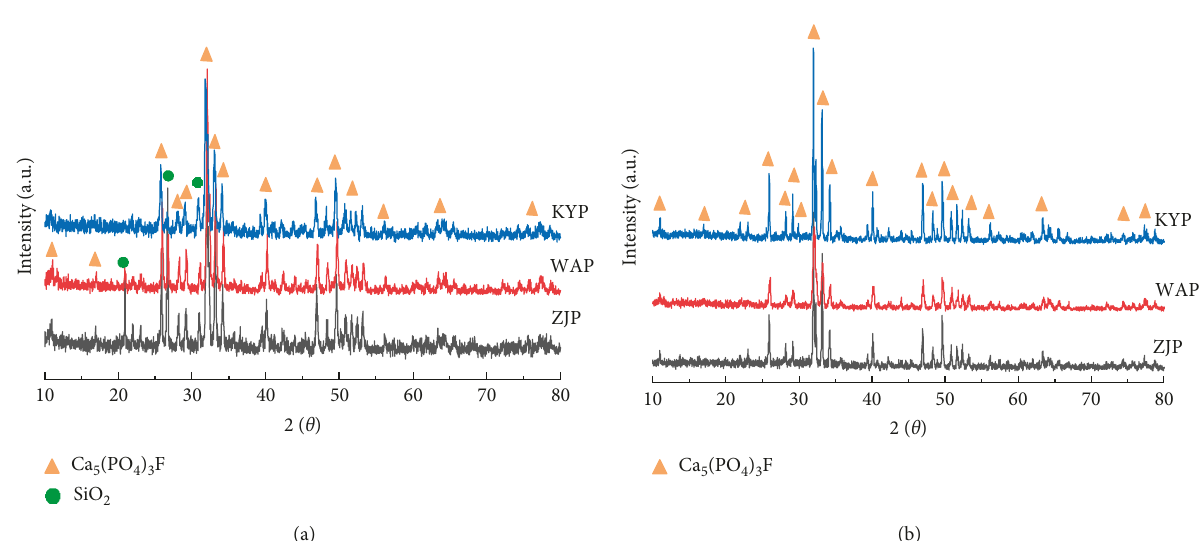
Figure 5: XRD patterns of phosphate rocks: (a) original sample; (b) after TPO-IR